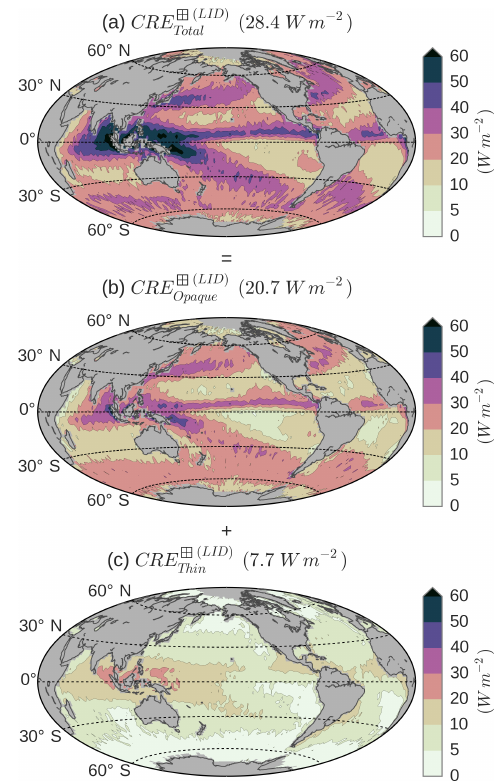
Figure 10. Maps of (a) the total CRE (b) the opaque CRE and (c) the thin CRE. Only nighttime conditions over ice-free oceans for the 2008–2015 period are considered. Global mean values are given in